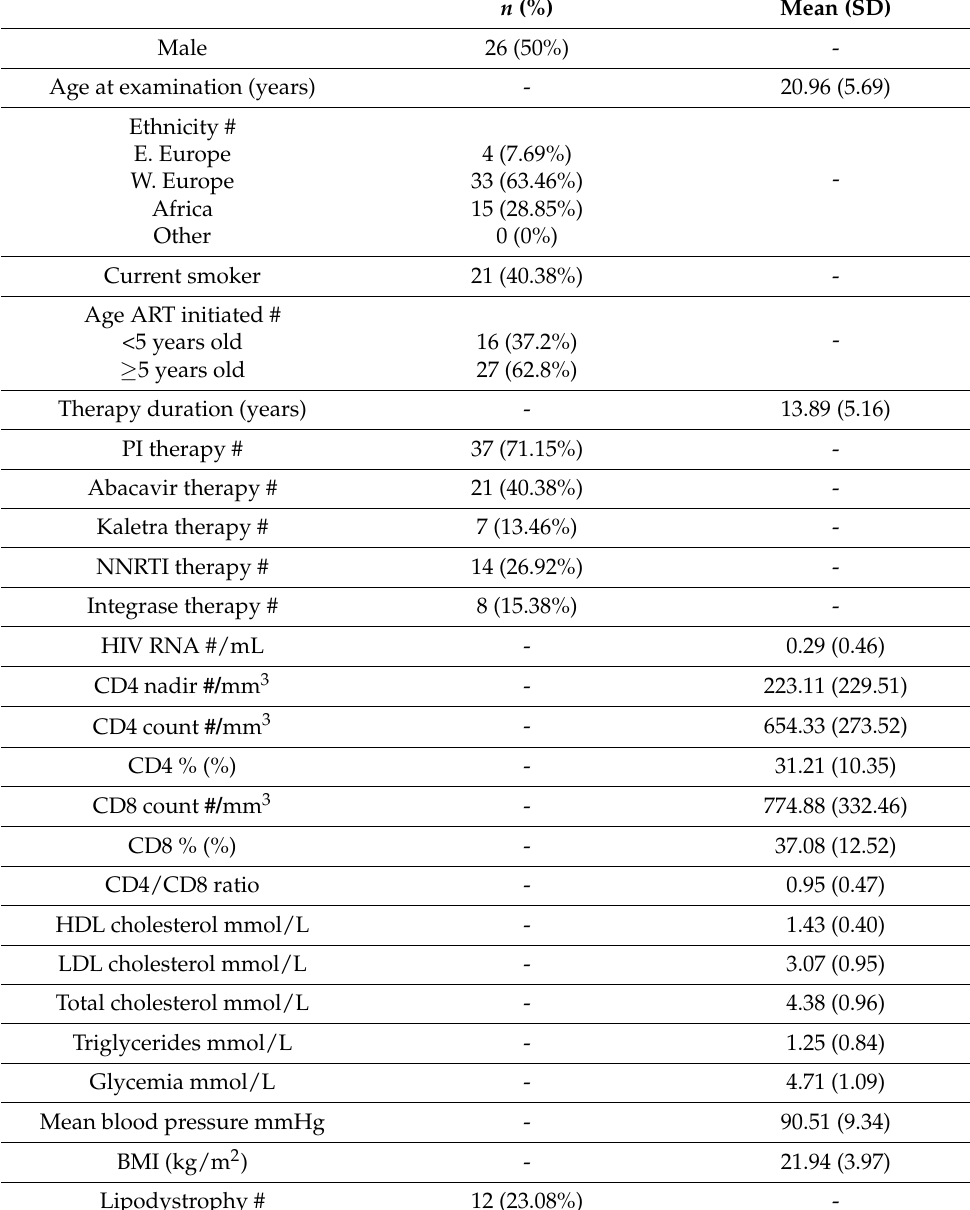
Table 1. Descriptive statistics (sex, age, ethnicity, traditional cardiovascular risk factors assessment, virological and immunological status and therapy characteristics). Data are shown as number (#), (%) or mean